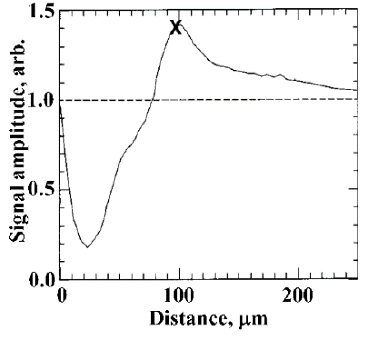
Figure 5. The scanning photoacoustic signal amplitude change. The visible defect is between 0 and 97 µm (“X” marking); reproduced from [60] with permission from The American Institute of Physics © 2000.